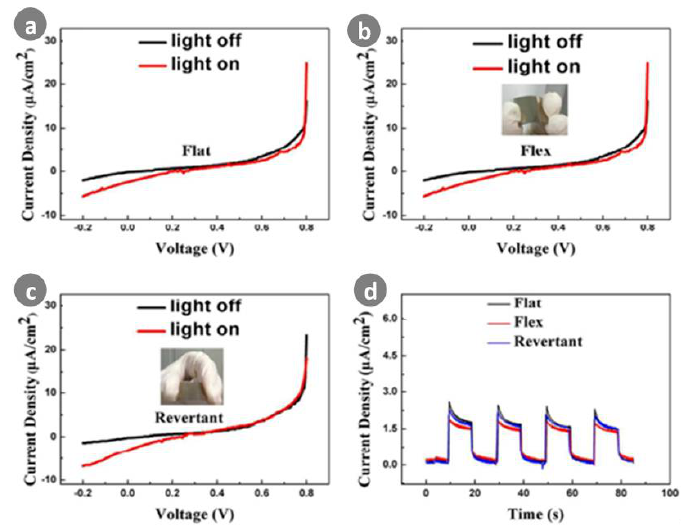
Figure 16. ( a ) I–V characteristics of ZnO nanowires based detector (sample 1) working in the original status in darkness and under the illumination of 60 µ W/cm 2 of UV light ( λ = 365 nm); ( b ) I–V characteristics of ZnO nanowires based detector working in the bending status; ( c ) I–V characteristics of ZnO nanowires based detector working in the status after the removal of bending force; ( d ) Photocurrent response of ZnO nanowires based device in three working conditions (flat, flex, revertant) under on/off radiation of 60 µ W/cm 2 of UV light ( λ = 365 nm). Ref. [132]. Copyright Royal Society of Chemistry.